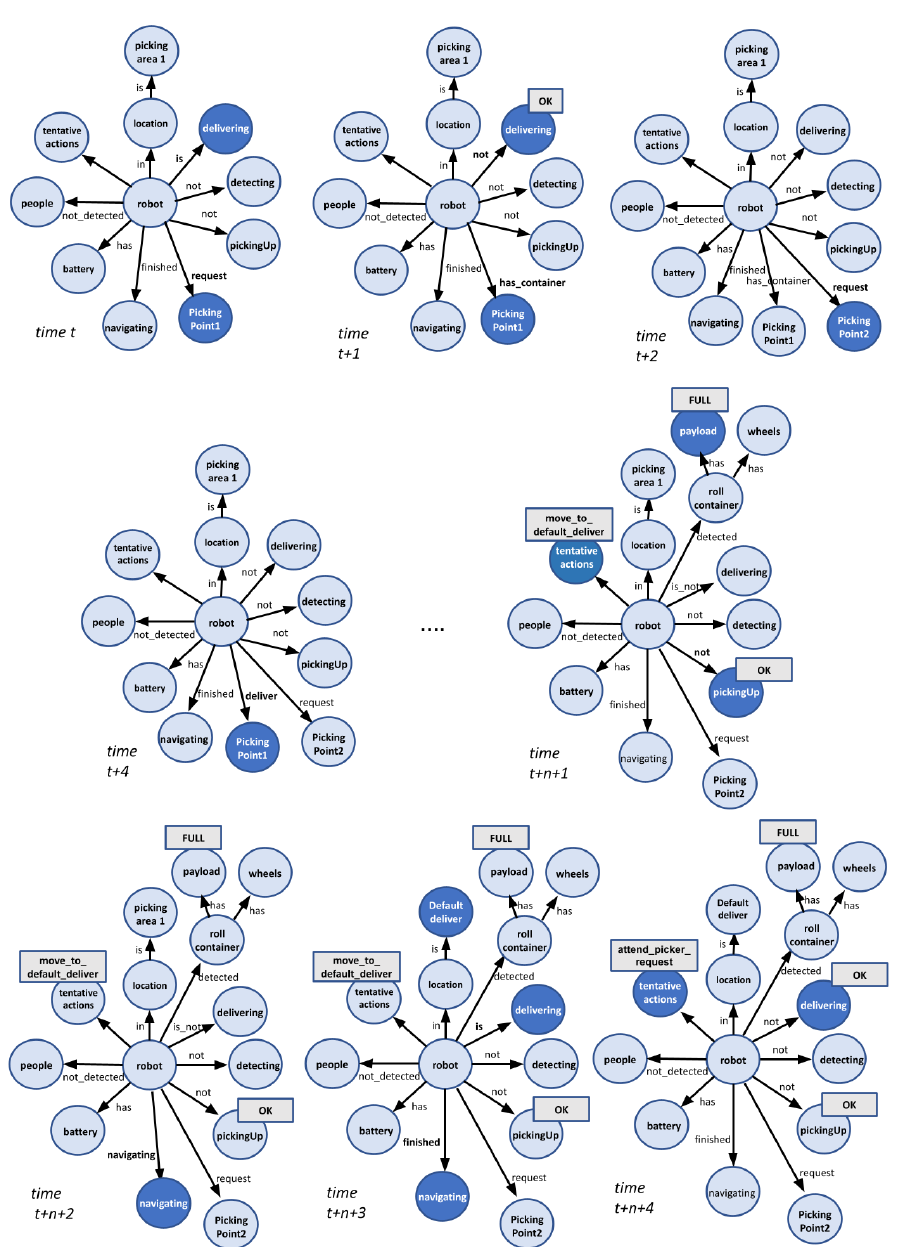
Figure 9. Modification of the nominal course of action: the roll container is FULL and the robot aborts the delivering of this container to a second picking area for continuing its load (see